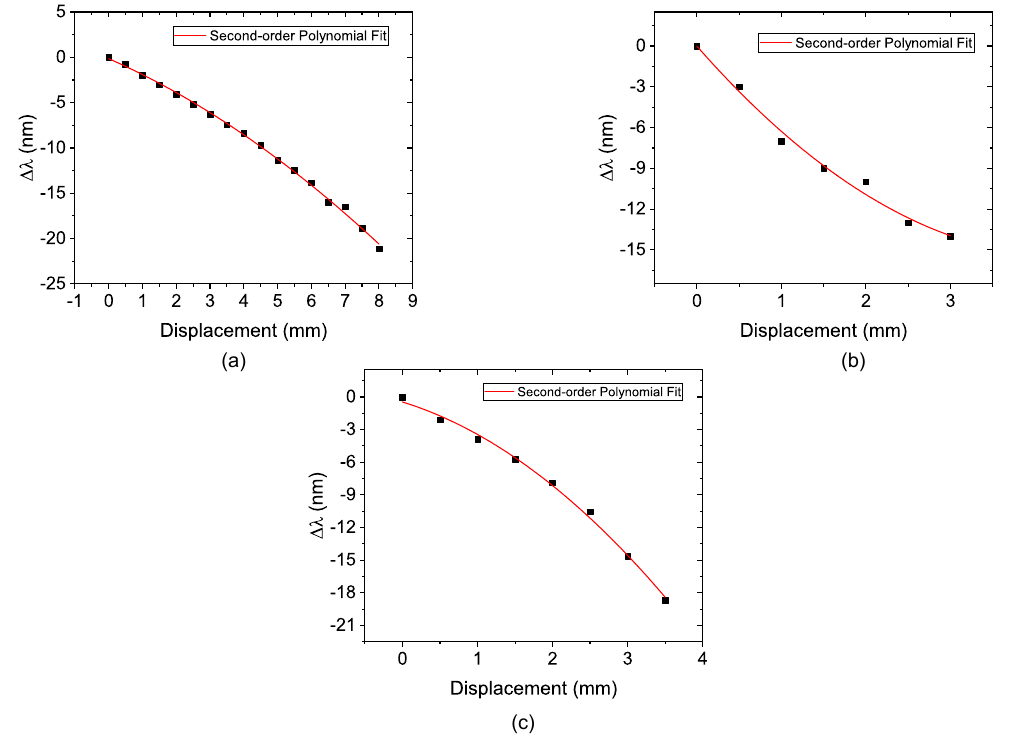
Figure 11. Wavelength shift as a function of displacement with D S = 110 mm and ( a ) the sensor with FP = 5 mm; ( b ) the sensor with FP = 10 mm; ( c ) the sensor with FP = 15